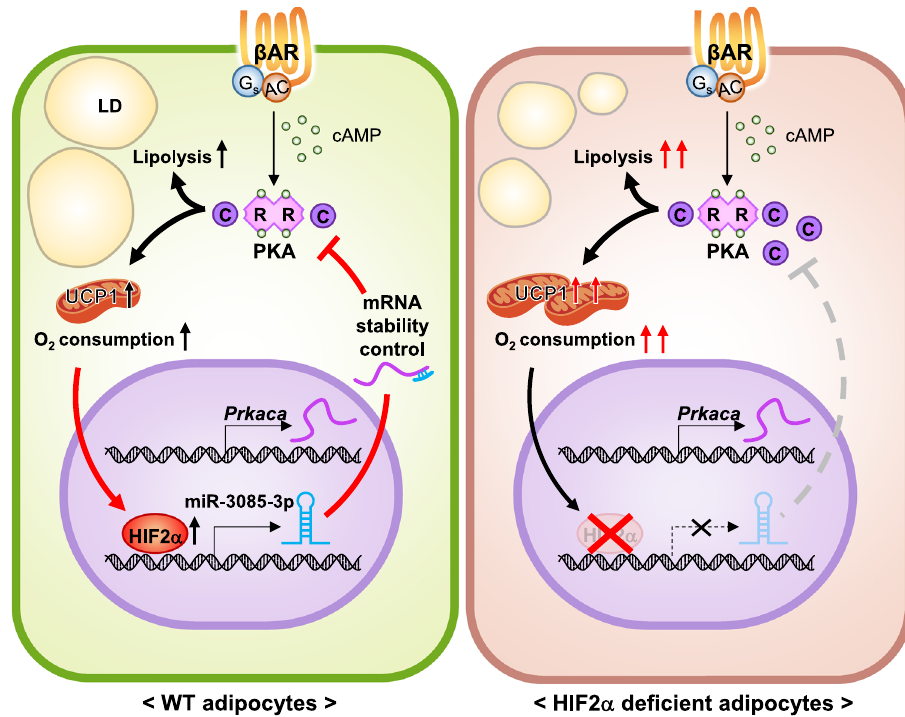
Fig. 8 Proposed model. Upon cold exposure, an activated thermogenic program in beige adipocytes stimulates oxygen consumption, thereby resulting in the stabilization of HIF α . Among the HIF α isoforms, upregulated HIF2 α fi ne-tunes thermogenic execution via miR-3085-3p-dependent Prkaca regulation. However, adipocyte HIF2 α de fi ciency augments PKA signaling and potentiates thermogenic functions, leading to the retention of beige adipocytes. Our fi ndings suggest that the HIF2 α -miR-3085-3p-PKA C α axis forms negative feedback for appropriate regulation of